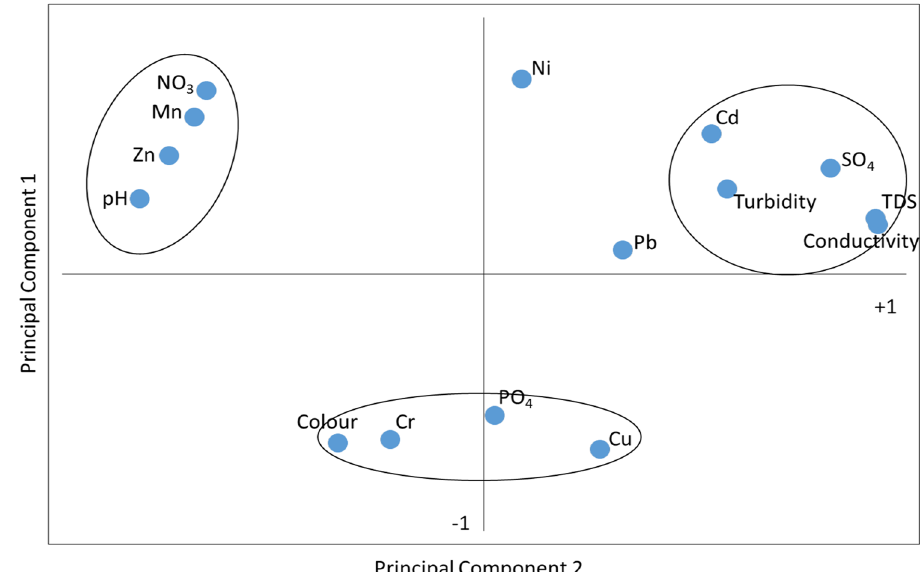
Fig. 2 Factor ordination and cluster of physicochemical properties of the non-roof har- vested